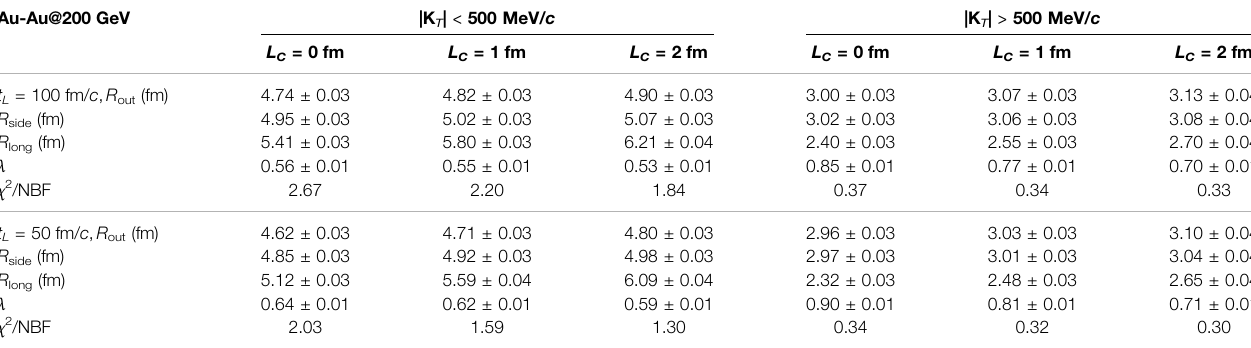
TABLE 1 | Fitted results of HBT radii and λ parameter in Eq. 9 for sources with L C = 0, 1, and 2 fm in central Au-Au collisions at ranges K T < 500 MeV/ c and K T > 500 MeV/ c . t L values are 100 and 50 fm/ c , and ratios of χ 2 to the number of bins fi tted are also presented. Au-Au@200